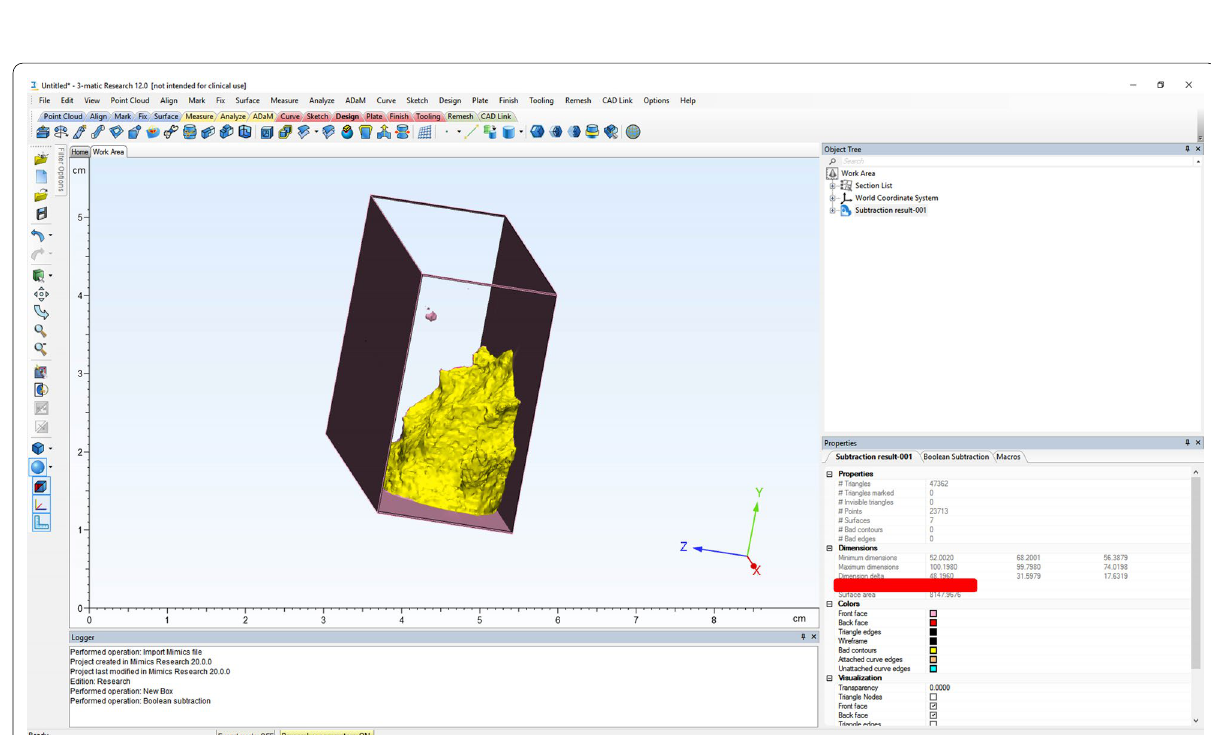
Fig. 4 Measuring the nasopharyngeal airway